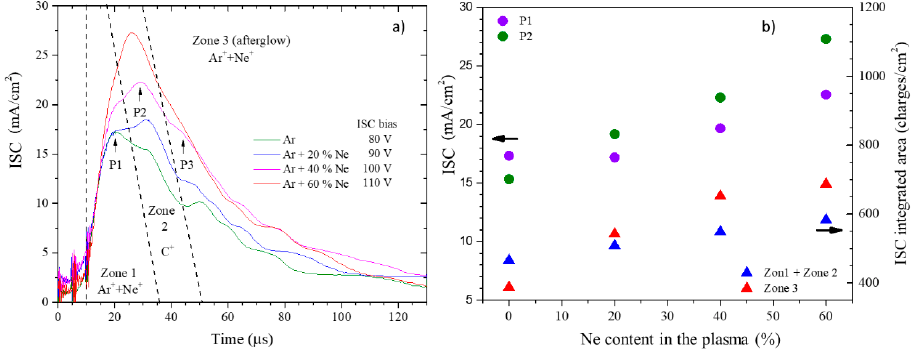
Figure 5. Ion saturation current ( a ), and area and maximum values of the ISC ( b ) as a function of the Ne content in the plasma.